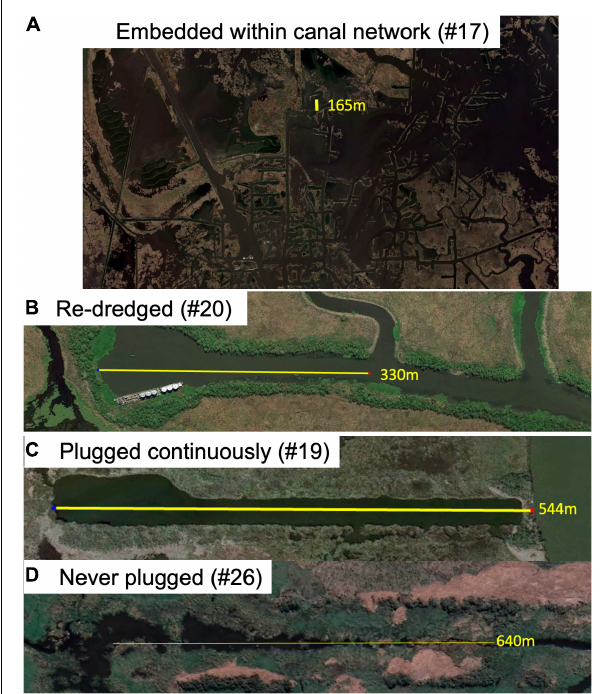
FIGURE 2 | Examples of canals backfilled under different conditions. (A) Backfilled canal #19 is surrounded by multiple layers of other canals, spoil banks and natural levees. Much of the former wetland is now open water. (B) Backfilled canal #20 was later re-dredged and spoil bank placed on either side in a continuous line, as before backfilling. (C) Canal #19 was plugged when backfilled and the plug remained decades later. (D) Canal #26 was never plugged. A yellow line goes down the center of each canal and its length is identified.